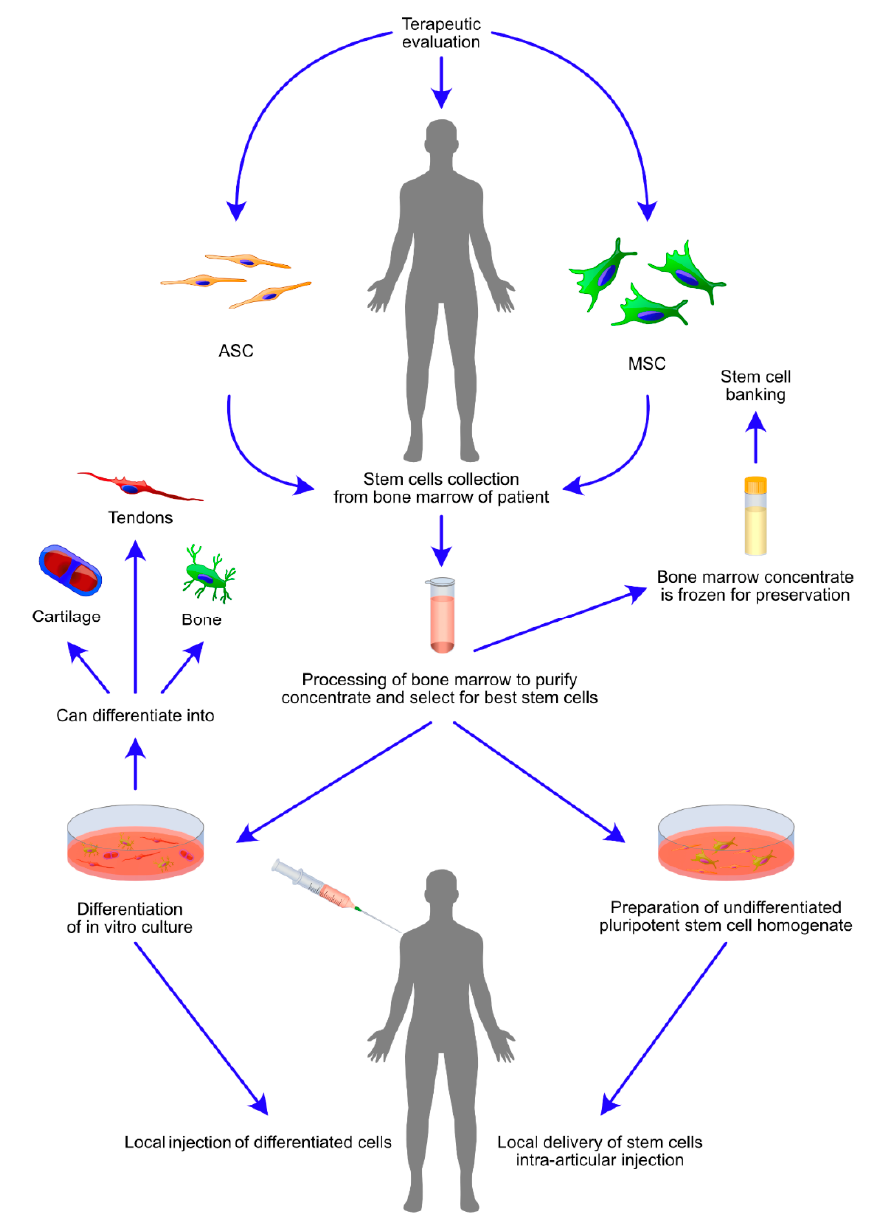
Figure 3. Therapeutically relevant events in administration of highly osteogenic mesenchymal stem cells (MSCs) and adipose stem cells (ASCs) for the treatment of osteogenic diseases. The schematic diagram presents steps crucial for intra-articular injection of bone marrow derived stem cells (BMSCs). The figure further defines two routes of therapy delivery, first: stem cells are in vitro cultured and differentiated using conditioned medium, followed by local delivery; second: stem cells are intra articularly administered in an uncultured and undifferentiated form. The local delivery in both cases is intra-articular or performed at the site of bone defect or fracture. Clinical routine favours administration of MSCs and ASCs as soon as the stem cell homogenate is processed. However, it is also possible to freeze the cells for a further administration. The diagram is supplemented by graphical representation of potentially existing differentiation outcomes of bone marrow stromal cells (BMSCs), including the formation of bone, cartilage and tendons.